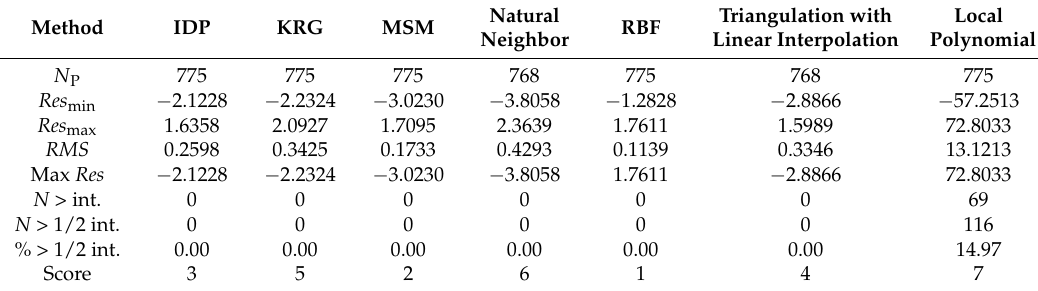
Table 1. Statistical analysis of interpolation residuals methods for gridding hanging-wall data. IDP: inverse distance to a power; KRG: Kriging; MSM: modified Shepard’s method; and RBF: radial basis function.